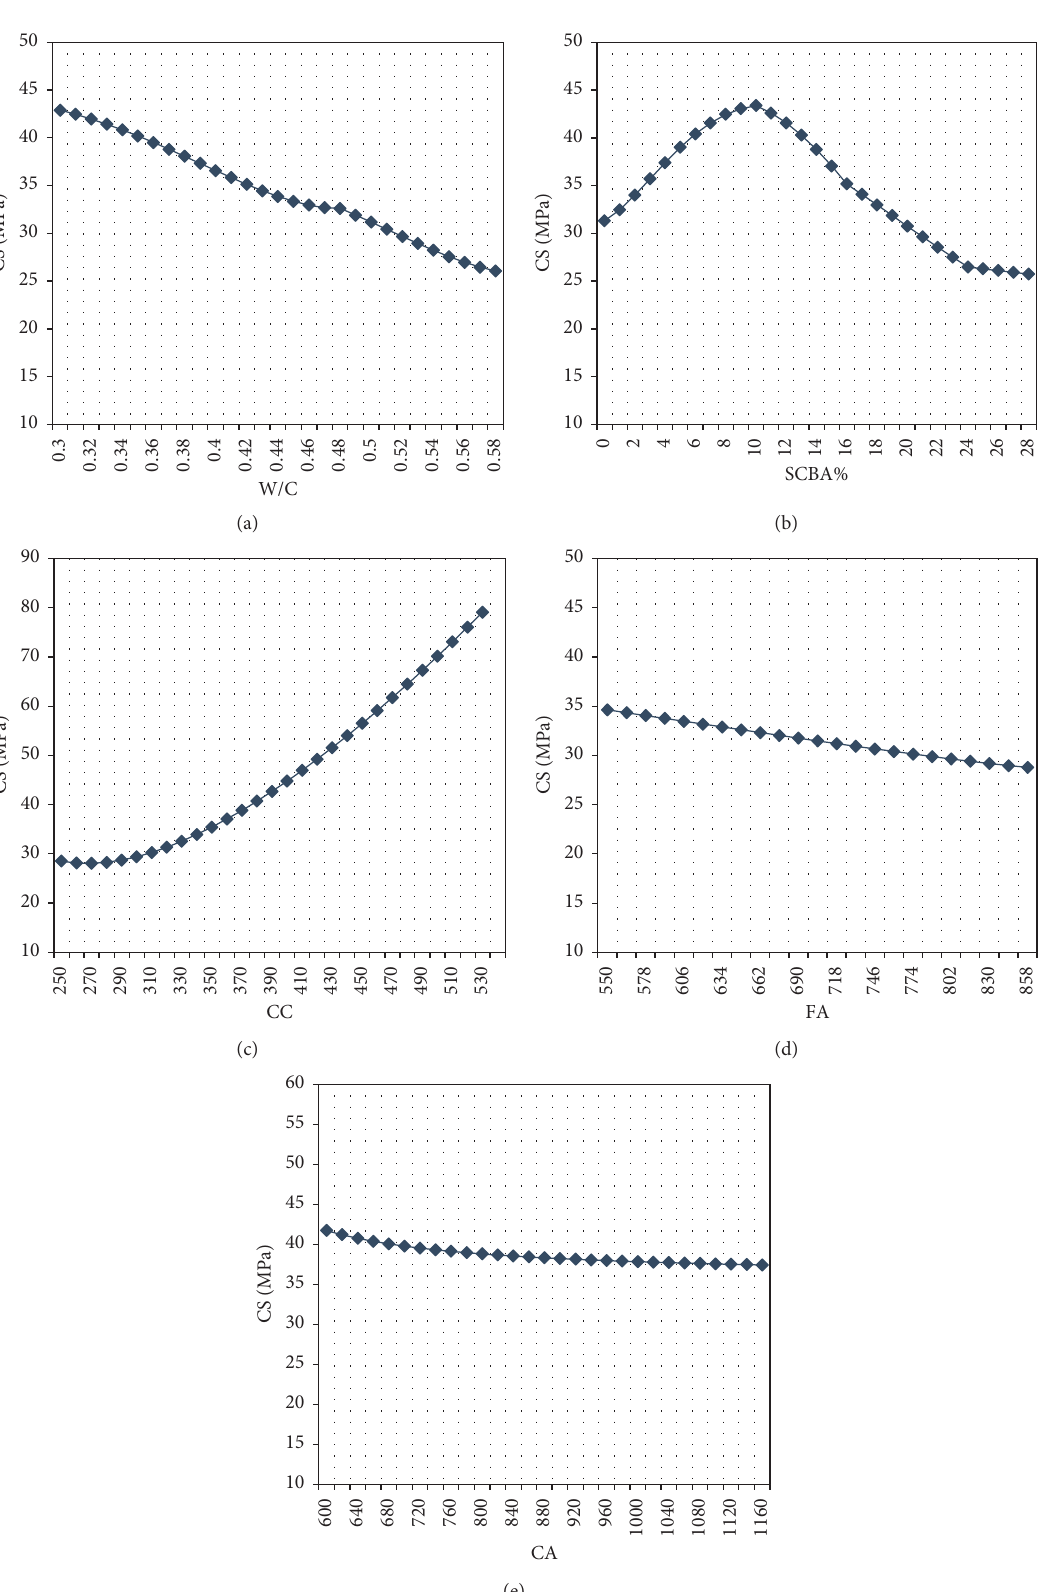
Figure 11: Parametric analysis results for (a) W/C, (b) SCBA%, (c) CC, (d) FA, and (e)